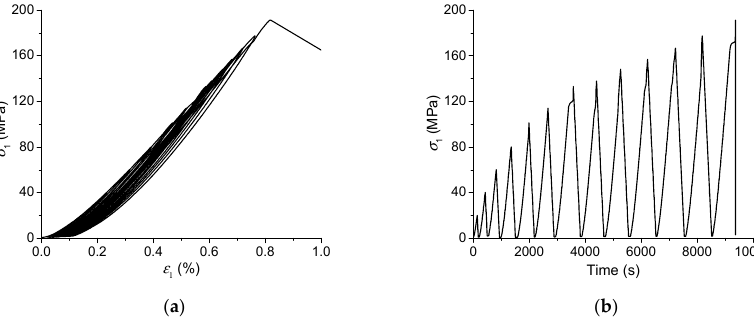
Figure 4. ( a ) Axial stress-strain curve obtained from the cyclic loading-unloading experiment on the sample with β = 30° under uniaxial compression ( σ 3 = 0 MPa); and, ( b ) axial stress–time curve of the same test to show the cycles of loading and unloading.